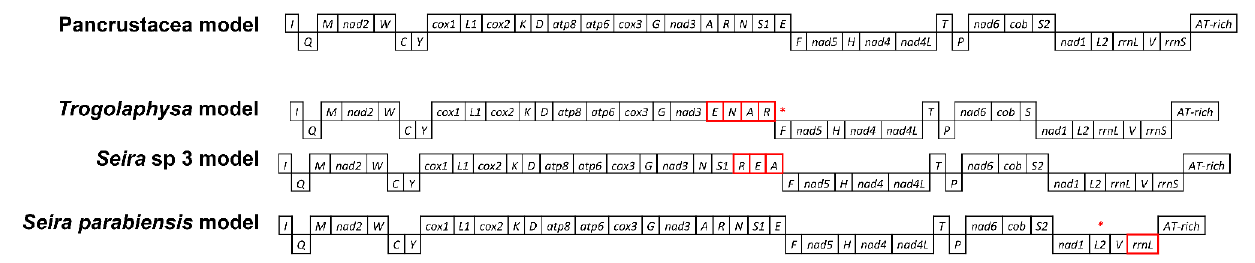
Figure 3. New gene order retrieved from the automatic annotation of [15] mitogenomic analysis compared to the ancestral Pancrustacean model. All derived gene arrangements, with respect to the basal model, show translocations as red boxes and deletions as asterisks (*). Table 1. Species used in the current study. Gene order column asterisks (*) indicate a compatible assignment to the already described gene order. Section signs ( § ) indicate manual curated sequences originally obtained by [20]. Order names are abbreviated. Further information is available in Table S3. See GenBank for reference of downloaded sequences.